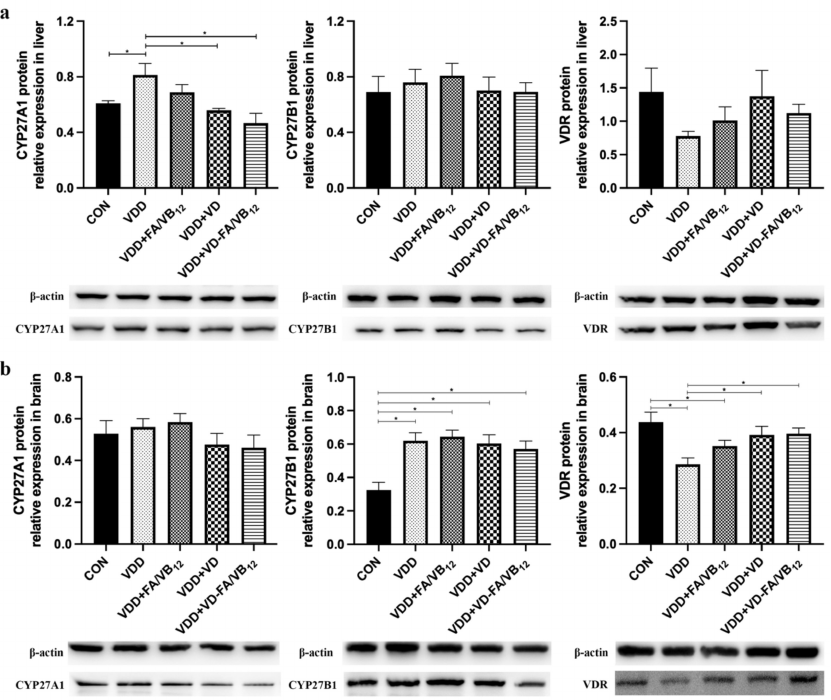
Figure 7. The protein expression of CYP27A1, CYP27B1, and VDR in liver and brain. ( a ) CYP27A1, CYP27A1and VDR protein in livers; ( b ) CYP27A1, CYP27A1and VDR protein in brains. CON: control; VDD: vitamin D-deficient diet; VDD + FA/VB 12 : vitamin D-deficient diet plus folic acid/vitamin B 12 supplement; VDD + VD: vitamin D-deficient diet plus vitamin D supplement; VDD + VD-FA/VB 12 : vitamin D-deficient diet plus vitamin D and folic acid/vitamin B 12 . All data are presented as the mean ± SEM ( n = 4). A two-sided p < 0.05 was considered statistically